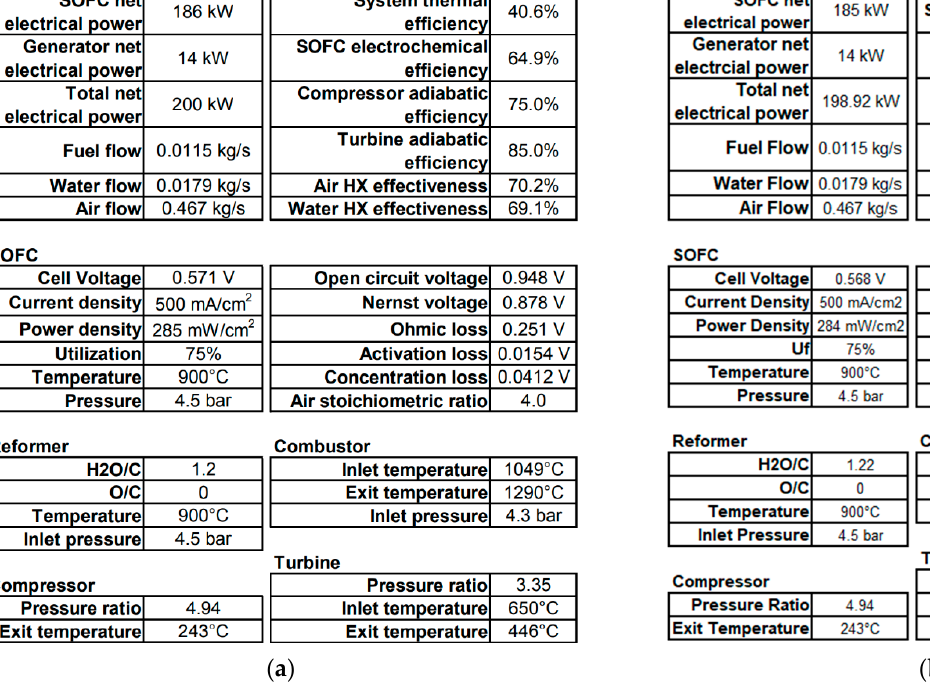
Figure 7. ( a ) NASA’s hybrid system results and ( b ) Our results with same process conditions.